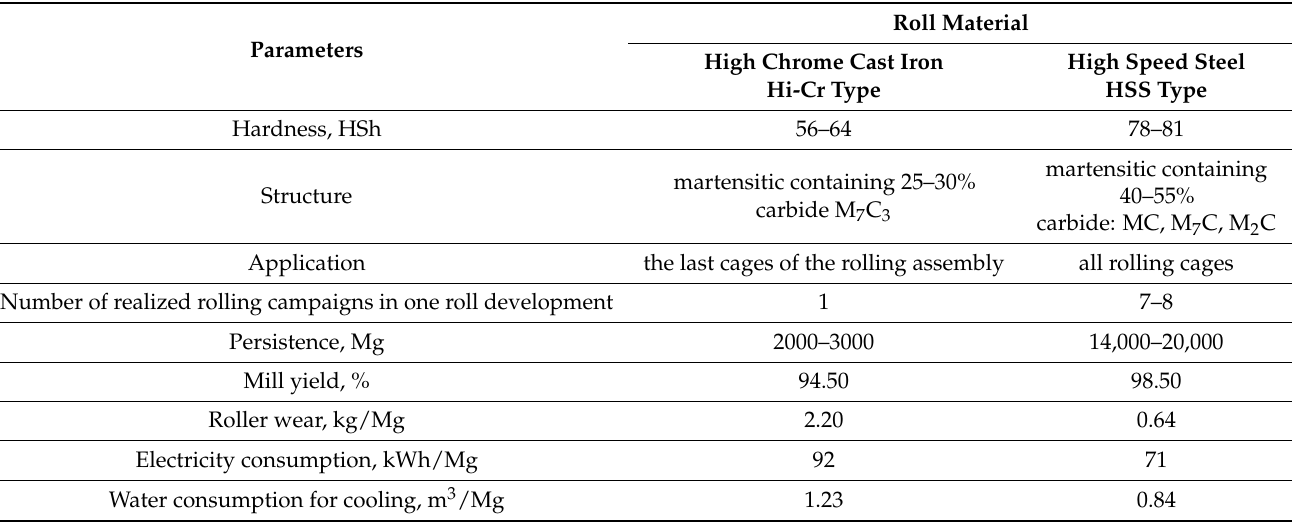
Figure 10. Cross-section through a high-speed steel cylinder after a campaign: ( a ) without etching, ( b ) with etching (2% Nital) [38]. Table 7. Comparative analysis of the influence of the performance parameters of rollers made of grades Hi-Cr and HSS on the quality of a finished